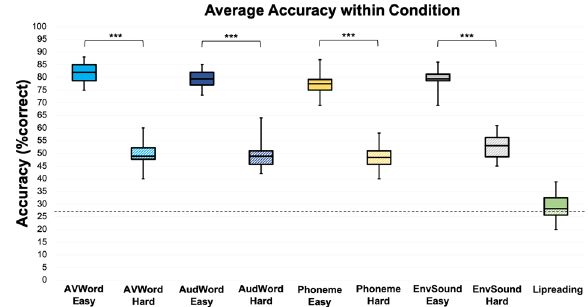
Fig. 3 Behavioral scores for each of the eight stimulus types and the lipreading task. All tasks were 4AFC identi fi cation tasks. The dotted line represents chance-level performance. Box plots are formatted in the following way: center line is the median; box limits are the upper and lower quartiles; whiskers are 1.5× interquartile range. (Signi fi cance levels: * = p < 0.05, ** = p < 0.01, *** = p <